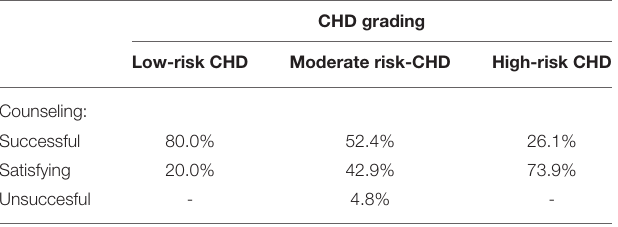
TABLE 3 | Overall counseling success in percent of total depending on the grading of the diagnosed congenital heart disease (CHD) ( n = 61).